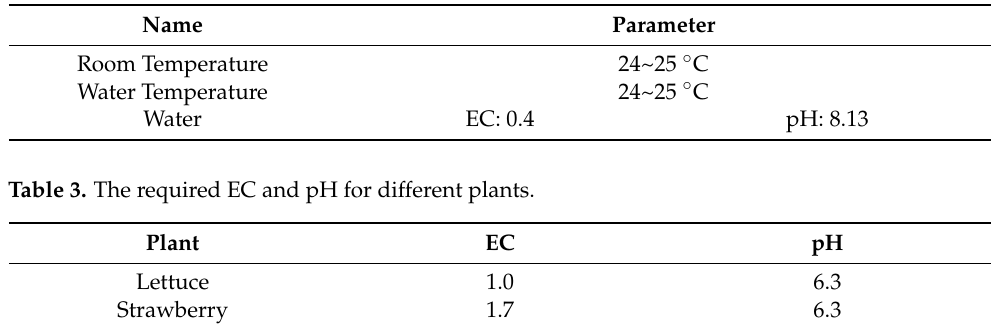
Table 2. Basic water quality conditions.